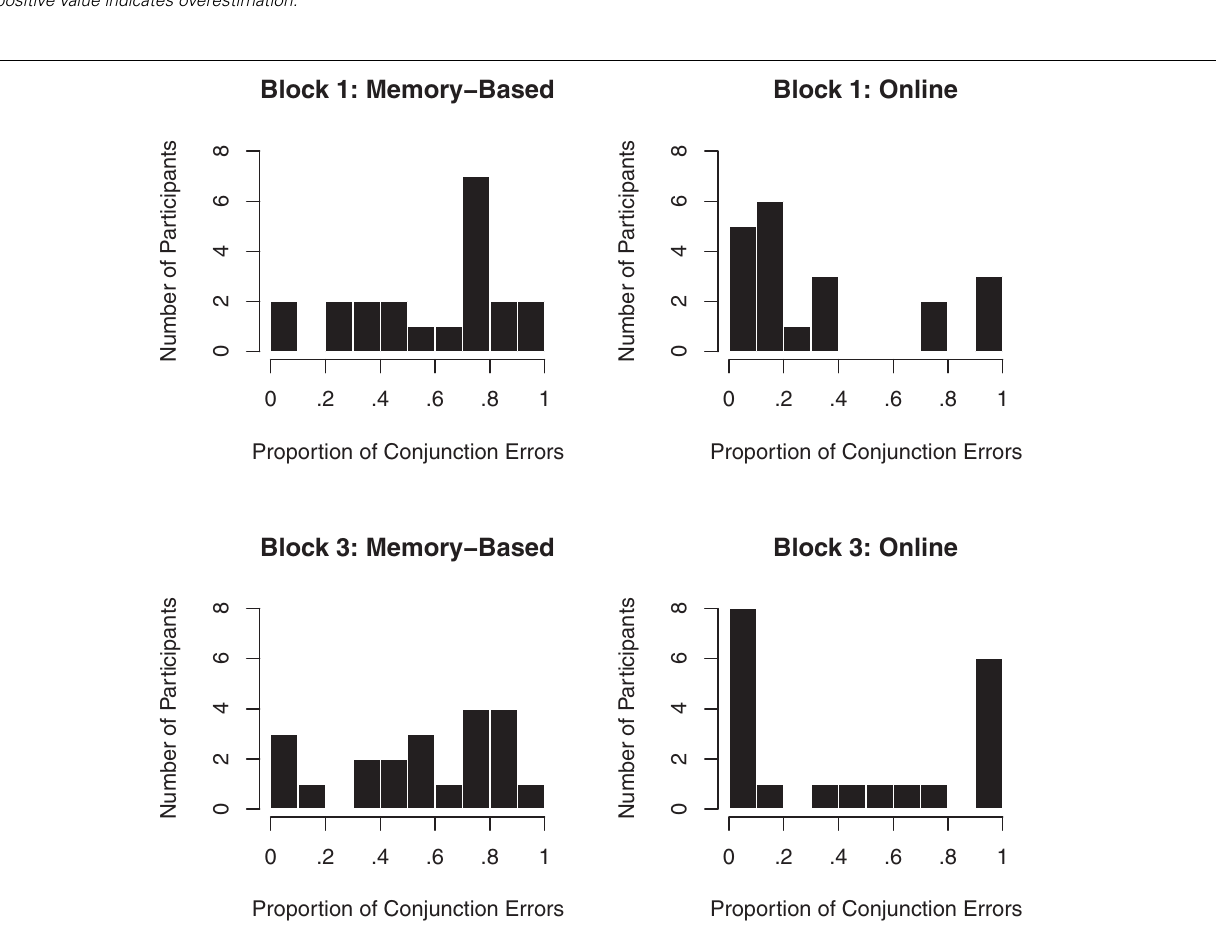
participants. Notably, four of the five participants with a decreas- ing r in the last two blocks had an intermediate conjunction error rate (i.e., they belonged to the middle cluster in the lower right panel of Figure 2 ). Given the binominal distribution of r ,